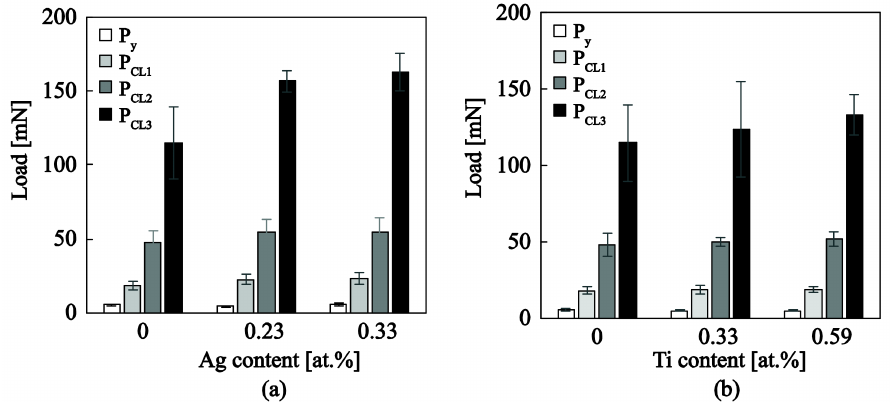
Figure 11. Critical loads for yield, cracking and delamination as quantified through scratch tests for ( a ) a–C:H:Ag and ( b ) a–C:H:Ti.